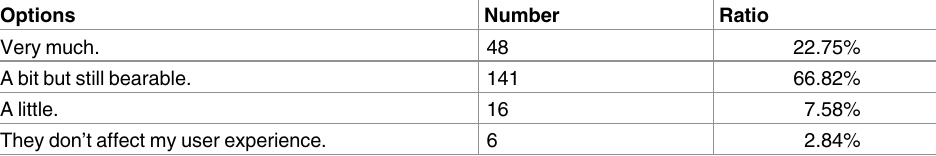
Table 1. How much do content polluters affect your user experiencewhen using social network sites?